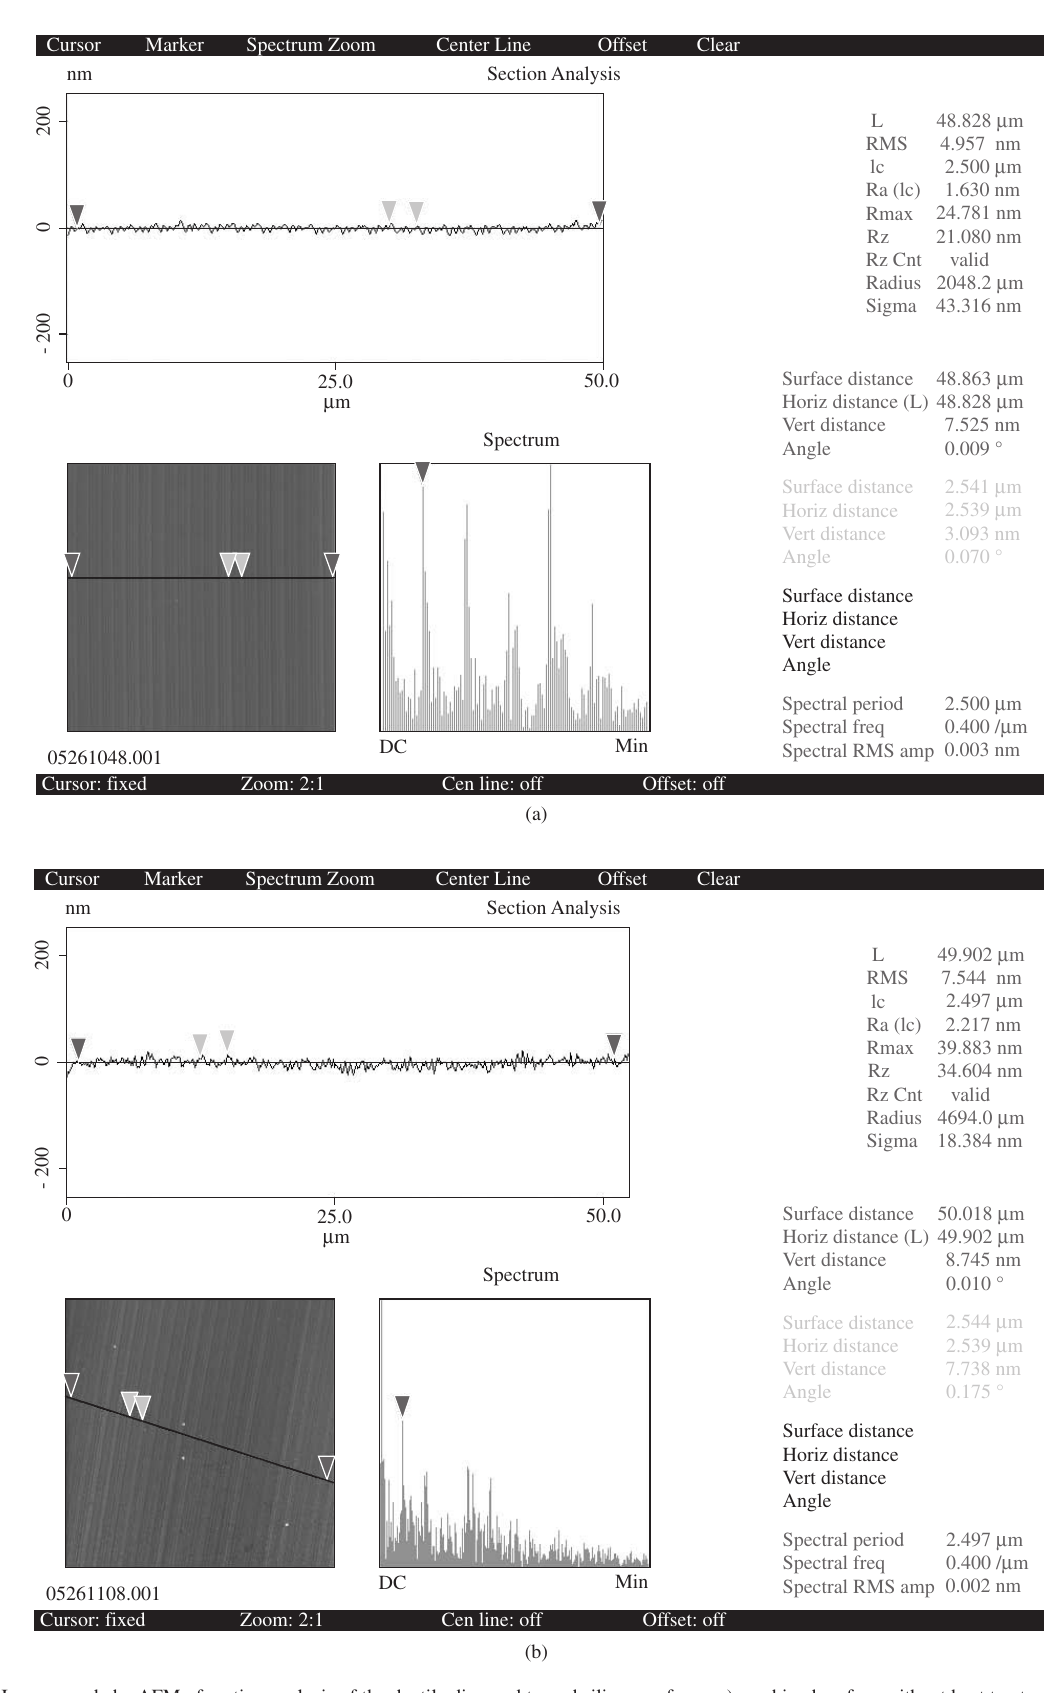
Figure 11. Images made by AFM of section analysis of the ductile diamond turned silicon surfaces: a) machined surface without heat treatment; and b) ma- chined surface after